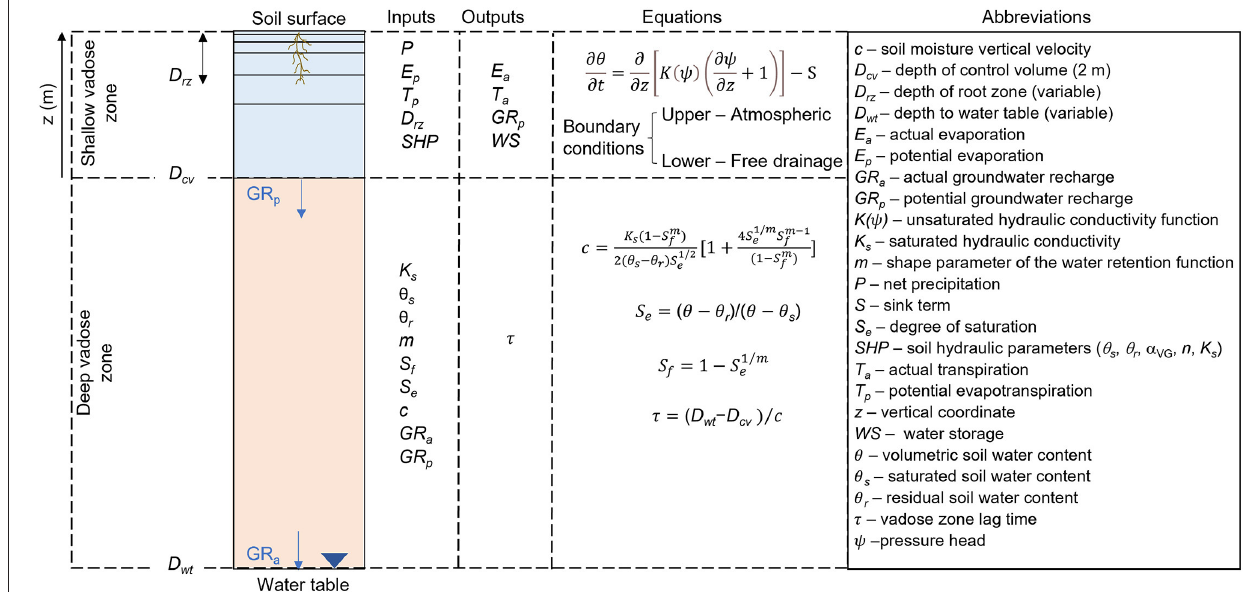
FIGURE 1 | Schematics of the soil profile split into shallow (blue rectangle) and deep (orange rectangle) vadose zone to estimate actual groundwater recharge (GR a ) depending on potential groundwater recharge (GR p ) and lag time ( τ ). All symbols are reported and explained in the following